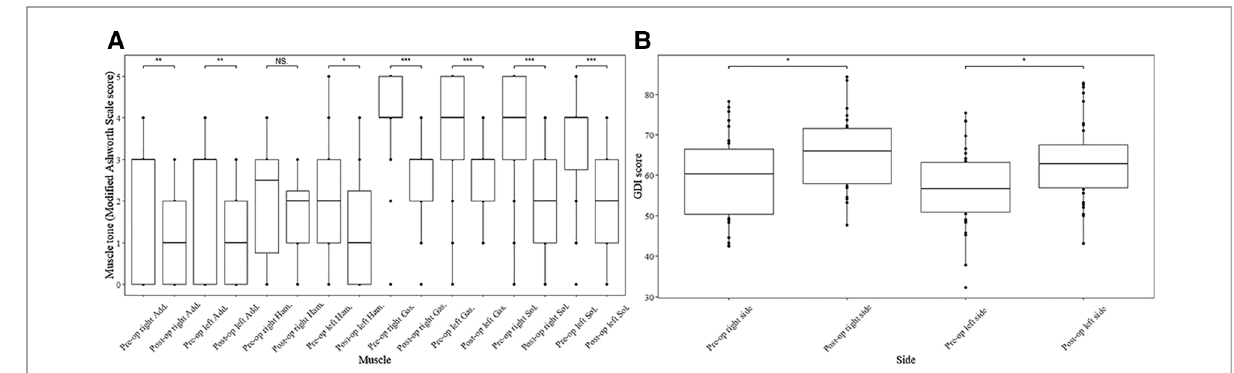
FIGURE 1 Muscle tone of muscles and gait deviation index (GDI) score of both limbs before and after SDR. Muscle tone change of muscles at both sides of lower limbs after selective dorsal rhizotomy assessed by modi fi ed Ashworth Scale score ( A ) and GDI score change of both sides after the surgery ( B ). Add., adductors; Ham., hamstring; Gas., gastrocnemius; Sol., soleus; GDI, gait deviation index; SDR, selective dorsal rhizotomy. * p <0.05, ** p <0.01, *** p <0.001.